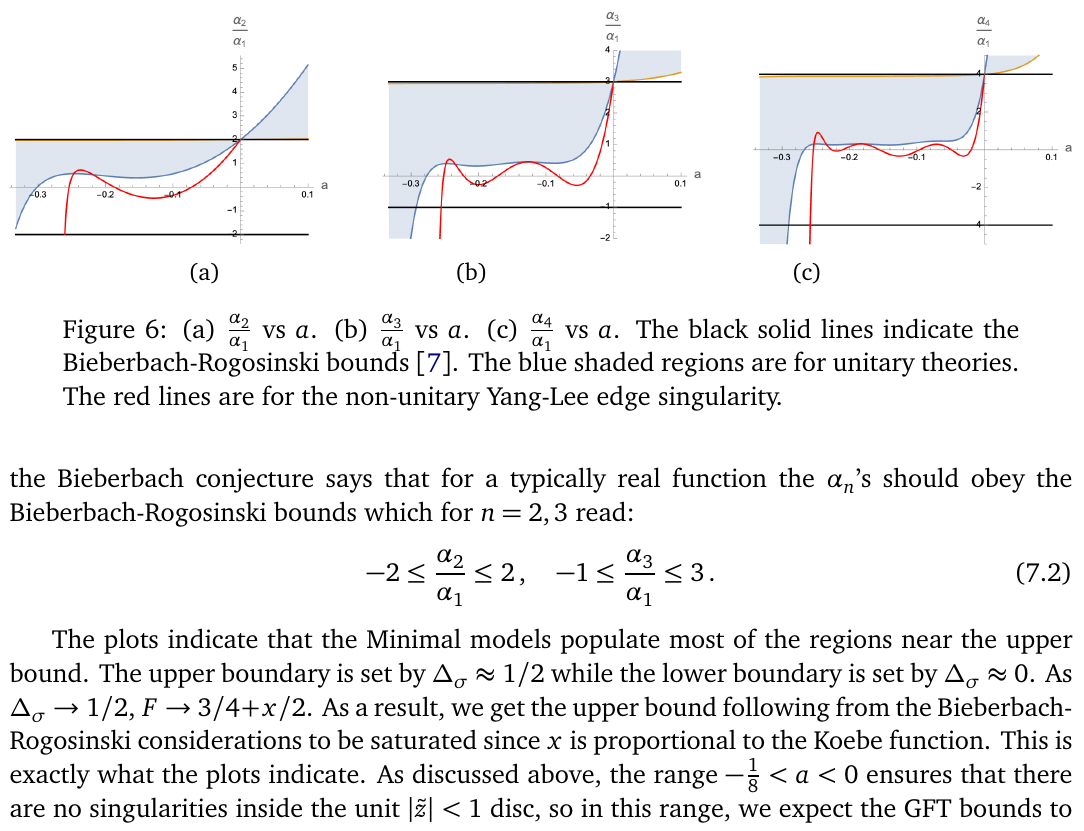
α α α 4 3 2 vs a . (b) vs a . (c) vs a . The black solid lines indicate the α α α 1 1 1